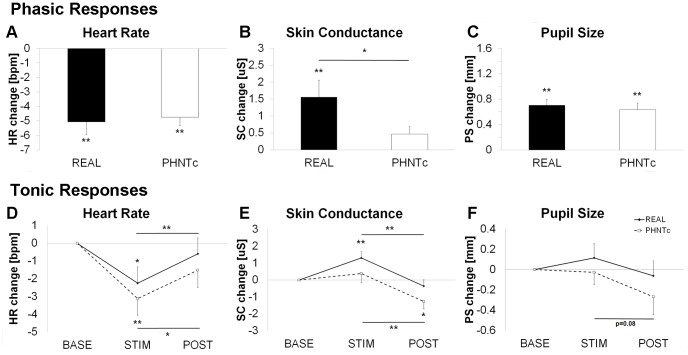
Influence of somatosensory needling on autonomic response modulation to real and phantom acupuncture.Phasic and tonic responses for heart rate (A and D), skin conductance (B and E), and pupil size (C and F) were contrasted between real (REAL) and credible (PHNTc) phantom acupuncture. Comparisons between REAL and PHNTc were based on the data collected only from subjects who regarded phantom acupuncture as real (i.e. PHNTc) and was done using paired t-tests. n.b. *<0.05, **<0.01. Error bars represent standard error of the mean.